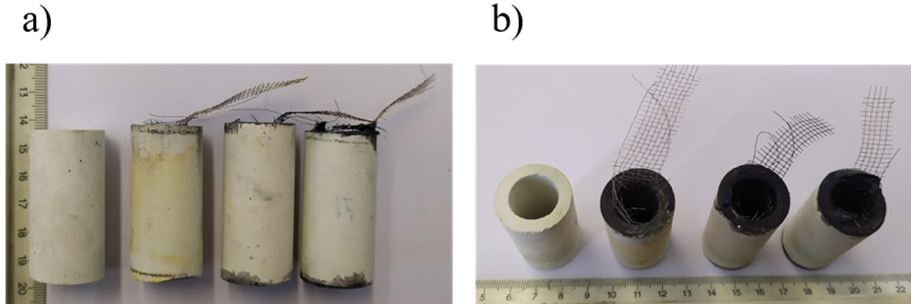
Figure 5. ( a ) Horizontal images and ( b ) vertical images of four mullite tubes with stainless steel mesh ( left to right : blank, WC, BC, and SC). Table 2. Physical properties of the three different produced cathode electrodes.